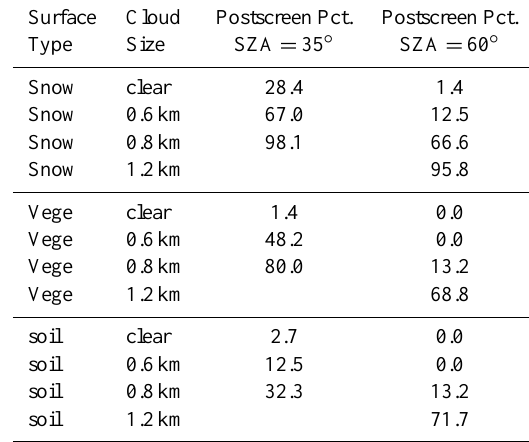
Table 4. Percentage of simulated observations identified as cloudy by postscreener algorithm. Postscreen